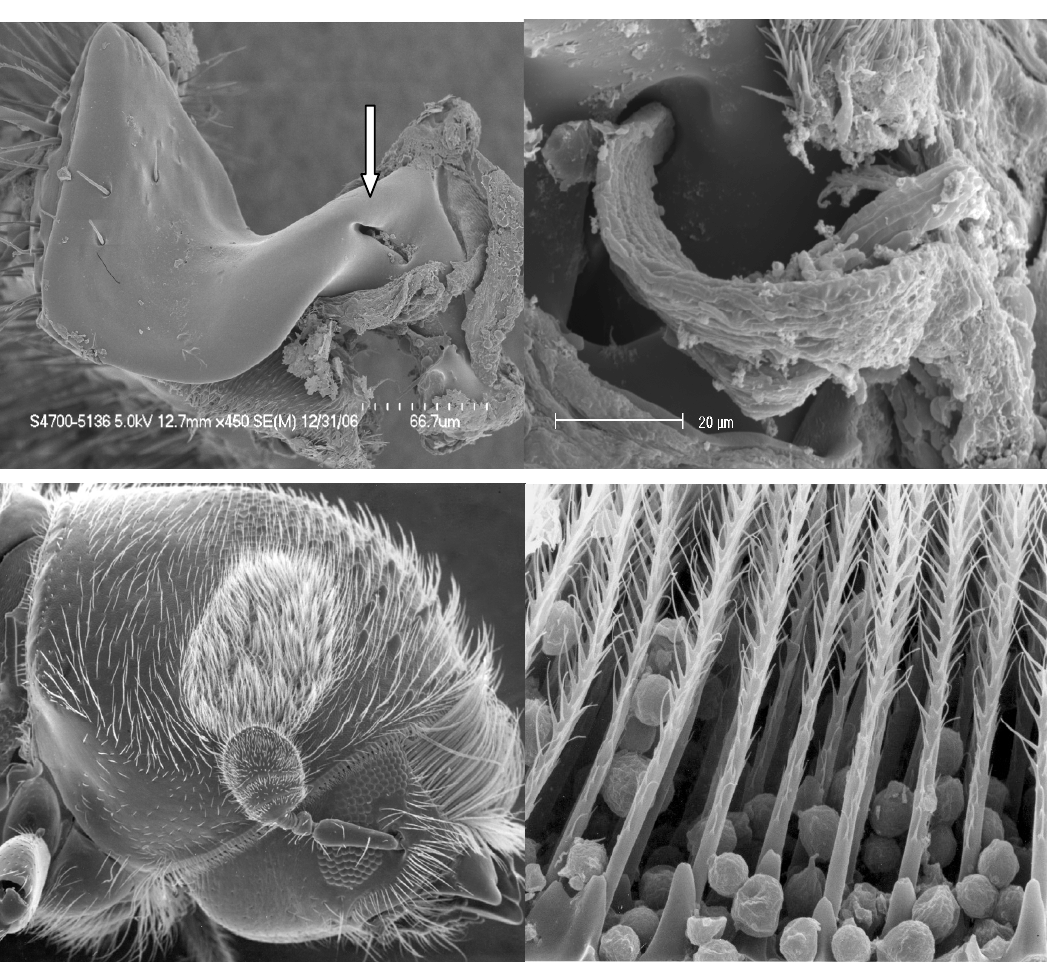
Figure 2. Examples of mycangia. From left to right, top to bottom: maxillary cardine of Dendroctonus ponderosae showing opening of sac mycangium (arrow) courtesy of Katherine Bleiker; Close up of mycangium of D. ponderosae showing fungal mass extruding from opening courtesy of Katherine Bleiker; Oval brush mycangium on female Pityoborus rubentris Mal Furniss; close up of brush mycangium of P. rubentris containing spores Mal Furniss; Ascospores in pit mycangium (puncture) of Ips pini Mal Furniss; mesonotal paired sac mycangia of Xylosandrus mutilates (dissected from beetle) courtesy of W. Doug